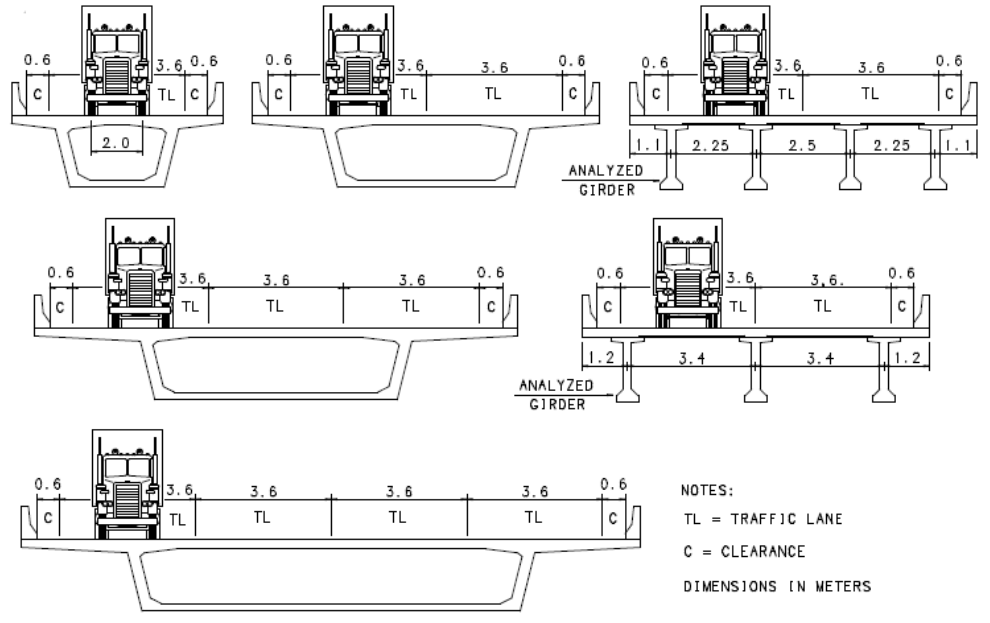
Figure 9. Cross-section of